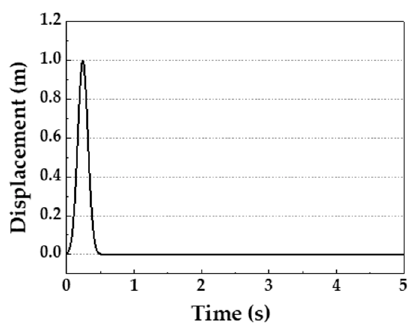
Figure 4. Finite element model of the cube.